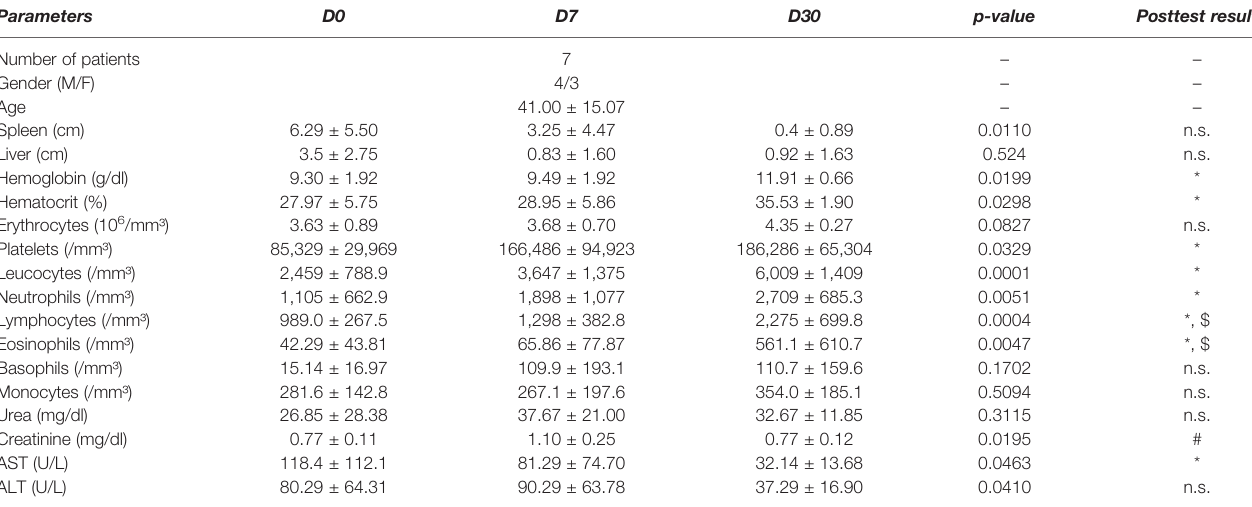
TABLE 1 | Clinical and laboratory data of patients with VL at different times of leishmanicidal treatment.